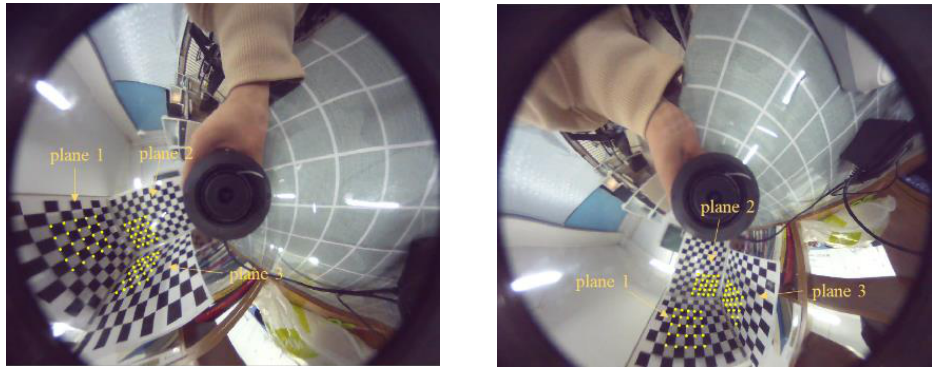
Figure 8. Two pictures of the trihedron taken by the omnidirectional camera. The points used for the 3D reconstruction are indicated by yellow dots.